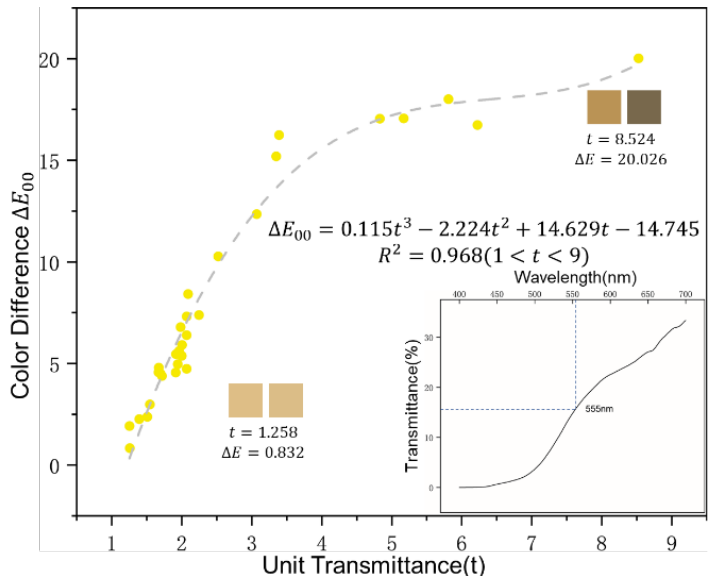
Figure 5. The highly positive correlation between the unit transmittance of sample and the color difference on different backgrounds. Data are shown in Supplementary Materials Table S4.